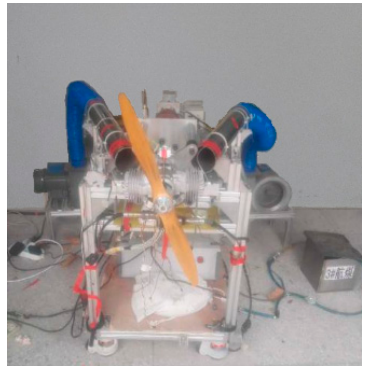
Figure 1. Fault diagnosis test platform for the engine control system.